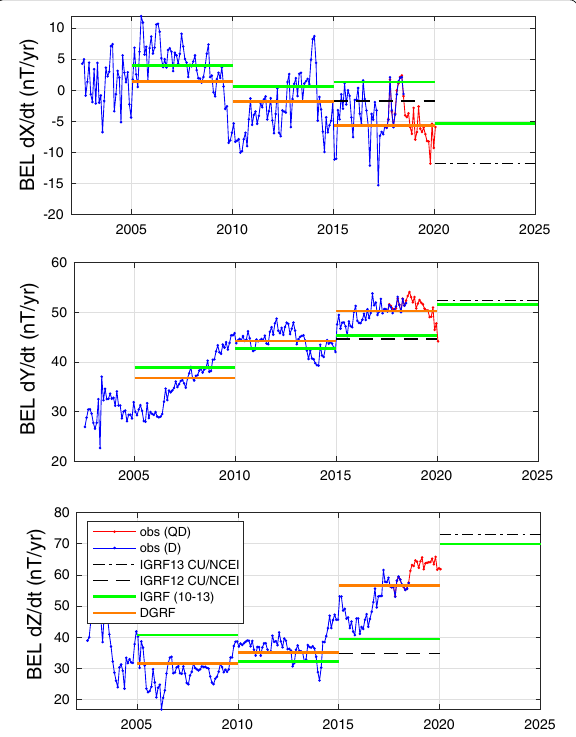
Fig. 5 Secular variation at Belsk observatory (BEL, 51.836 ◦ latitude, 20.789 ◦ longitude). Observatory annual differences from definitive (D) and quasi-definitive (QD) data. Model predictions from CU/NCEI SV candidate models to IGRF13 and IGRF12. Model predictions from IGRF10, IGRF11, IGRF12, IGRF13 SV models, and from the most recent DGRF